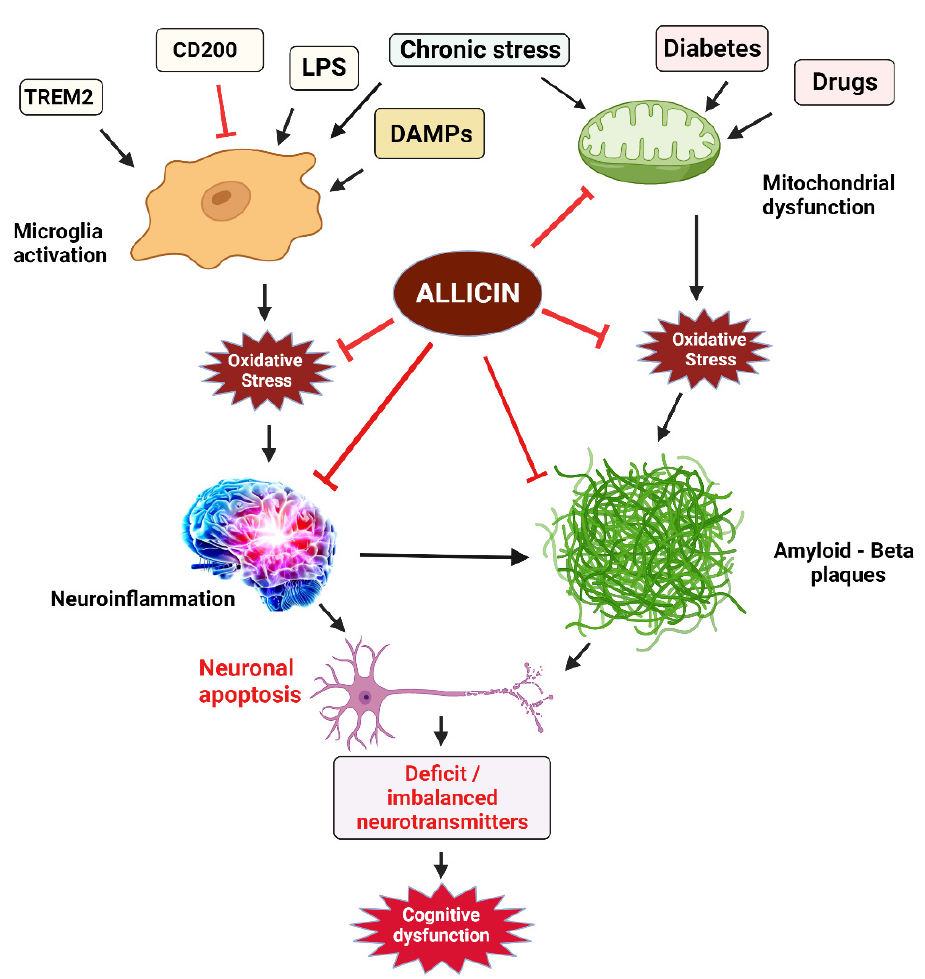
Figure 8. Role of allicin to ameliorate cognitive impairment adopted from various reports available in the literature.